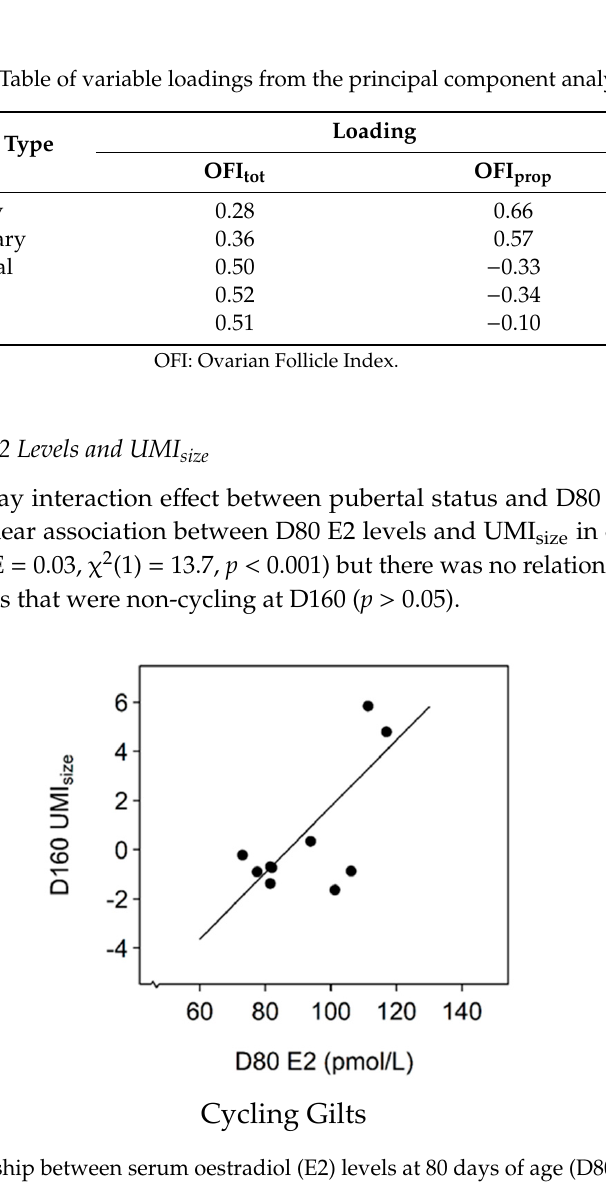
Figure 3. The relationship between serum oestradiol (E2) levels at 80 days of age (D80) and the Uterine Mass Index of size (UMI size ) in gilts that were cycling at D160 (slope = 0.13, SE = 0.03, χ 2(1) = 13.7, p < 0.001).